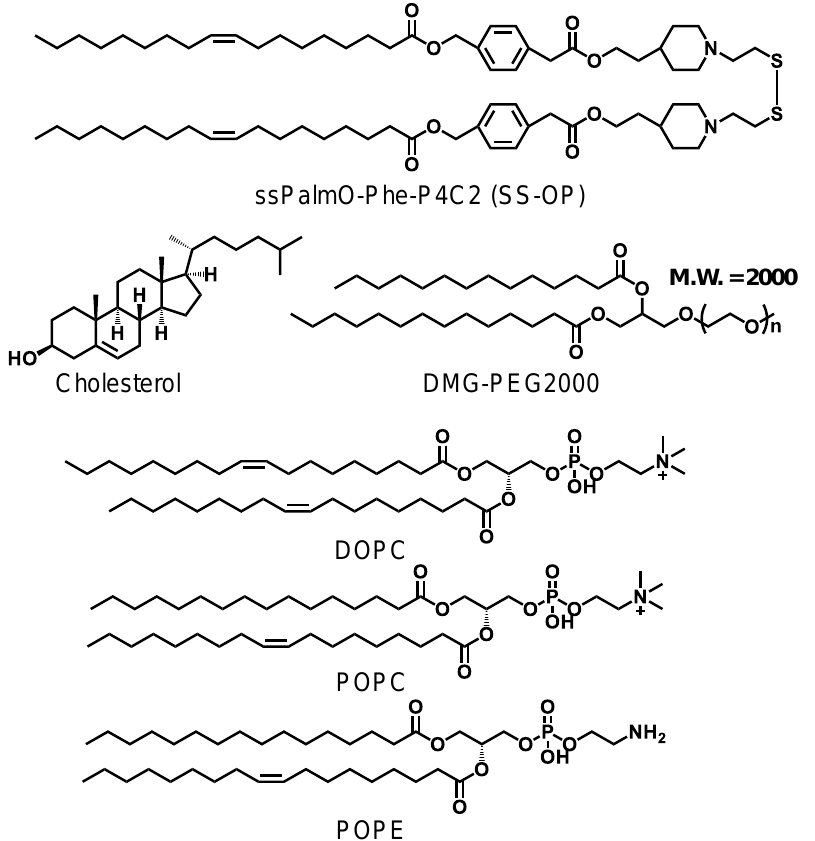
Figure 1. Chemical structures of the lipids used in this study. The chemical structure of the ssPalmO- Phe-P4C2, cholesterol, 1-(Monomethoxy polyethylene glycol 2000)2,3-dimyristoylglycerol (DMG- PEG2000), 1,2-dioleoyl-sn-glycero-3-phosphatidylcholine (DOPC), 1-palmitoyl-2-oleoyl-sn-glycero- 3-phosphatidylcholine (POPC), and 1-palmitoyl-2-oleoyl-sn-glycero-3-phosphatidylethanolamine (POPE) were shown.